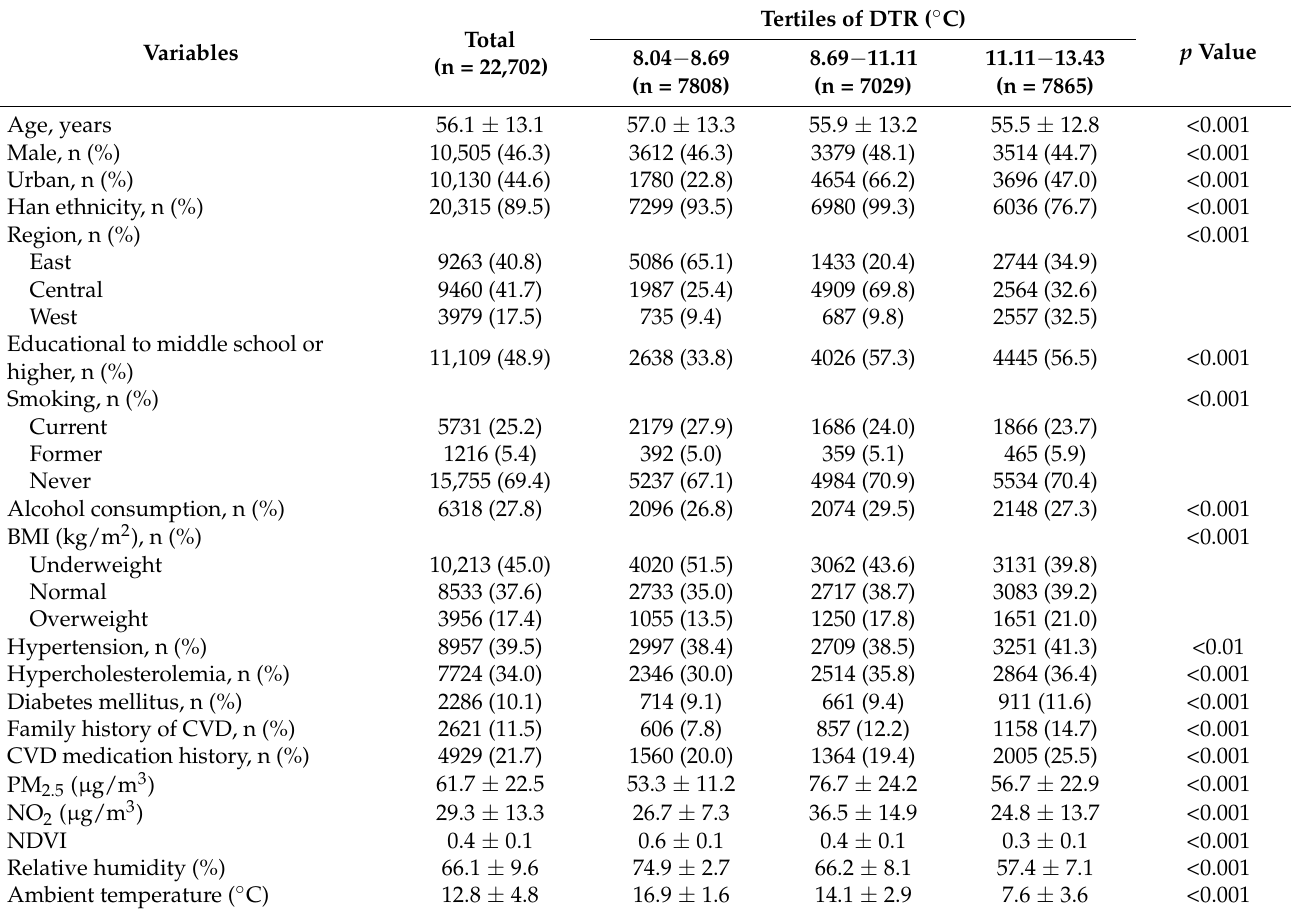
Table 1. Baseline characteristics of China Hypertension Survey participants overall and stratified by tertiles of diurnal temperature